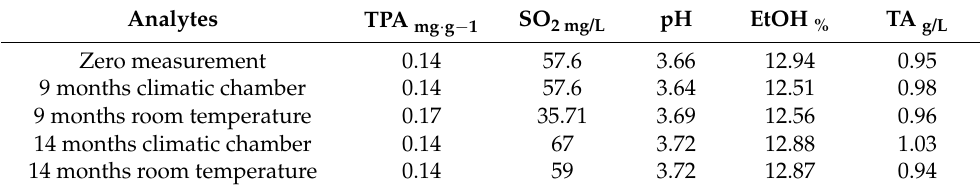
Table 10. Basic oenological parameters. Biologically active substances. Pinot Noir dry. Basic oenological parameters . Sample E—Pinot noir dry, harvest